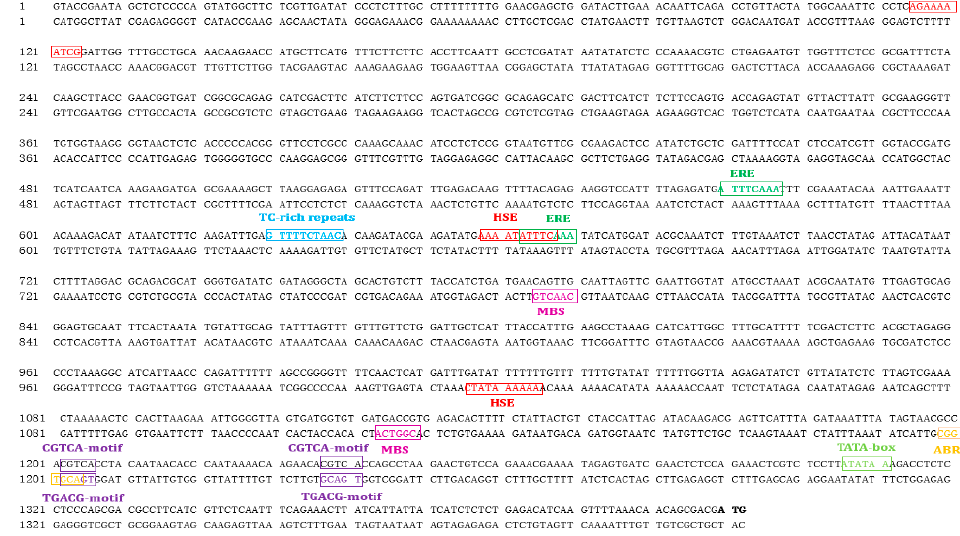
Figure 2. 1409 bp upstream of the start code are shown as the BocMBF1c promoter. DNA elements in the BocMBF1c promoter were designated. The start code is designated as bold and the TATA box as grass green. Three heat shock elements (HSEs) are boxed in red, ethylene-responsive elements (EREs) in green boxes, ABA-responsive elements (ABREs) in yellow boxes, methyl jasmonate (MeJA)-responding elements in purple, MYB binding sites (MBS) in the purple red box, and TC-rich repeats as stress-responding elements in the blue box.